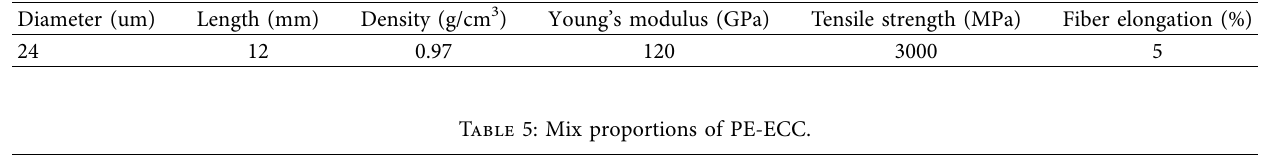
Table 4: Properties of the PE fiber.